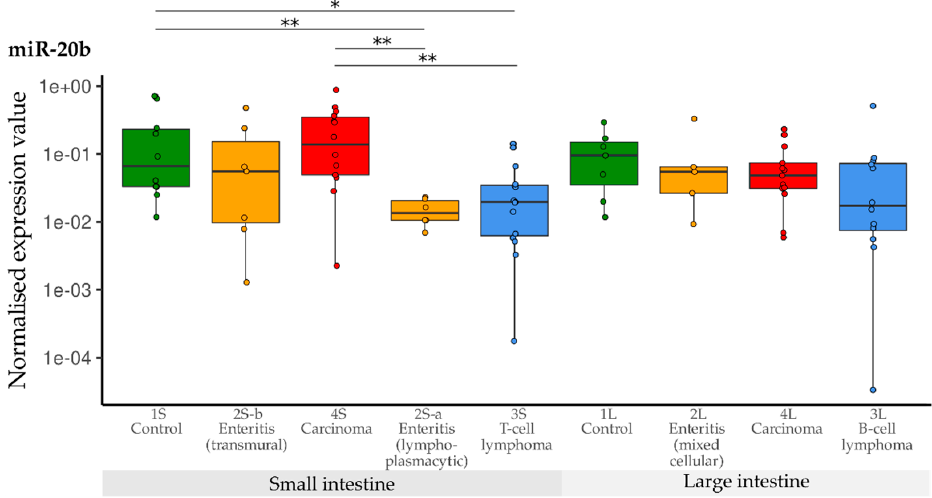
Figure 6. Expression levels of miR-20b in different groups (control, enteritis, carcinomas, lymphomas of the small and large intestine). The absolute miRNA copy number was related to the internal normaliser RNU6B. Results are shown as normalised expression values with a log10 scale. * p < 0.05, ** p < 0.005. Green control group, yellow enteritis, red carcinoma, blue lymphoma. pared with all other small intestine groups (1S, 2Sa, 2S-b, 4S). Expression of miR-192 was again significantly decreased in all three large intestine groups (2L, 3L, 4L) compared with